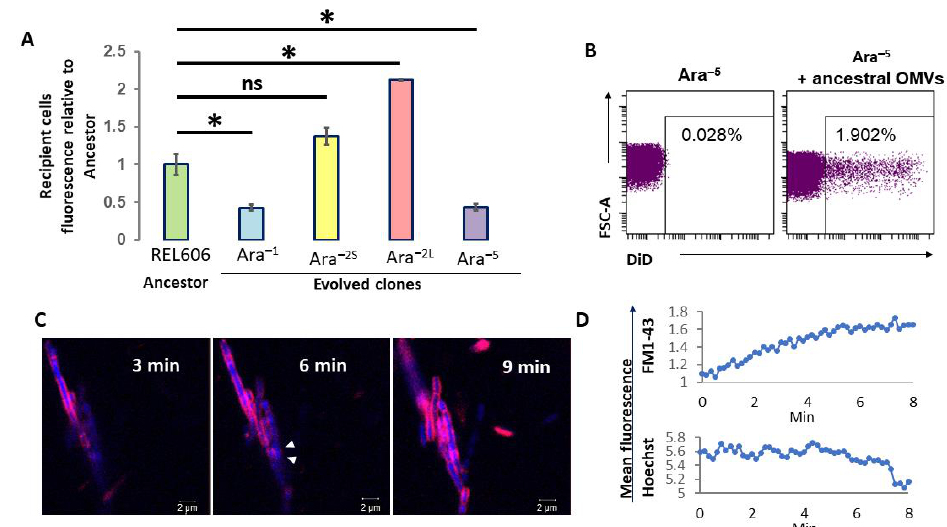
Figure 3. OMVs produced from the ancestral strain fuse with bacterial cells of the ancestral clone and 50K evolved clones. ( A ) Spectroscopic analysis. DiL-labelled OMVs from the ancestral strain were incubated with whole-cell suspension of the ancestral strain (REL606) and each of the 50K-evolved clones (Ara –1 , REL11330; Ara –2S , REL11335; Ara –2L , REL11333; Ara –5 , REL11339). Fluorescence levels acquired by each type of recipient bacteria were measured after 30 min of incubation, at 37 °C, and expressed relative to that measured for ancestral recipient bacteria. The experiment was performed 3 times, *: p < 0.05; ns: not significant. ( B ) Cytometric analysis. Cells of the Ara − 5 evolved clone were incubated with non-labelled (left panel) or DiD-labelled (right panel) OMVs from the ancestral strain and the frequency of labelled recipient cells was quantified by flow cytometry. The y axis (FSC: Forward Scatter) corresponds to the diameter of the detected bacterial cells, while the x axis corresponds to the intensity of the DiD fluorescence. Cells were gated to avoid bacterial auto-fluorescence and to detect DiD fluorescence only. ( C ) Live confocal microscopic analysis. FM1-43-labelled OMVs from the ancestral strain (red) were incubated at room temperature with bacterial cells of the Ara −5 evolved clone pre-labelled with Hoechst 33,342 (blue). White triangles indicate 2 FM1-43-labelled OMVs fusing with the same recipient bacterial cell. The 3 images were taken from a live 9-min sequence at 3, 6 and 9 min after addition of fluorescently labelled OMVs. This sequence is representative of 2 experiments performed with FM1-43 and one with DiL markers, all providing similar results. Some bacteria remained blue and did not fuse with OMVs. ( D ) 8 min-follow-up of the mean FM1-43 and Hoechst 33342 fluorescence intensities for one particular bacterial cell, as quantified by the ImageJ software using images similar to that presented in C.